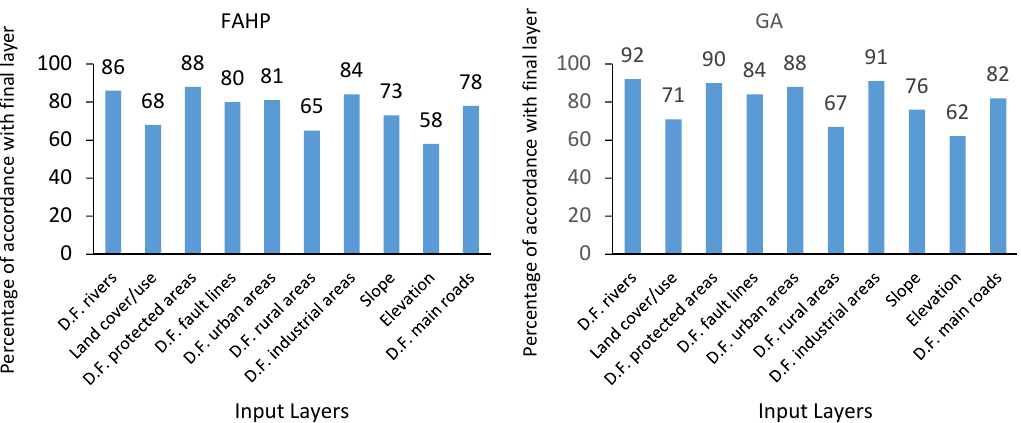
Fig. 10: Results of sensitivity analysis on fuzzy analytic hierarchy process and genetic algorithm